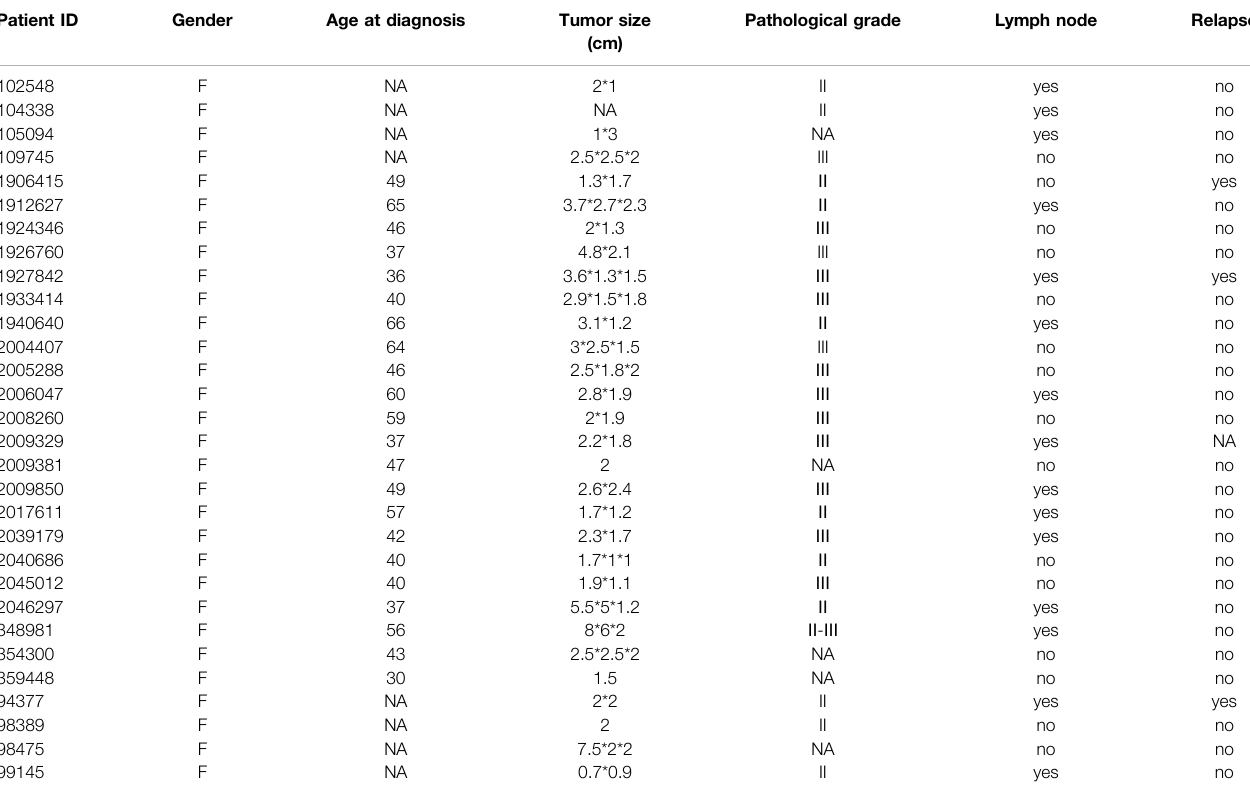
TABLE 1 | Clinical characteristics of 30 triple-negative breast cancer patients. Patient